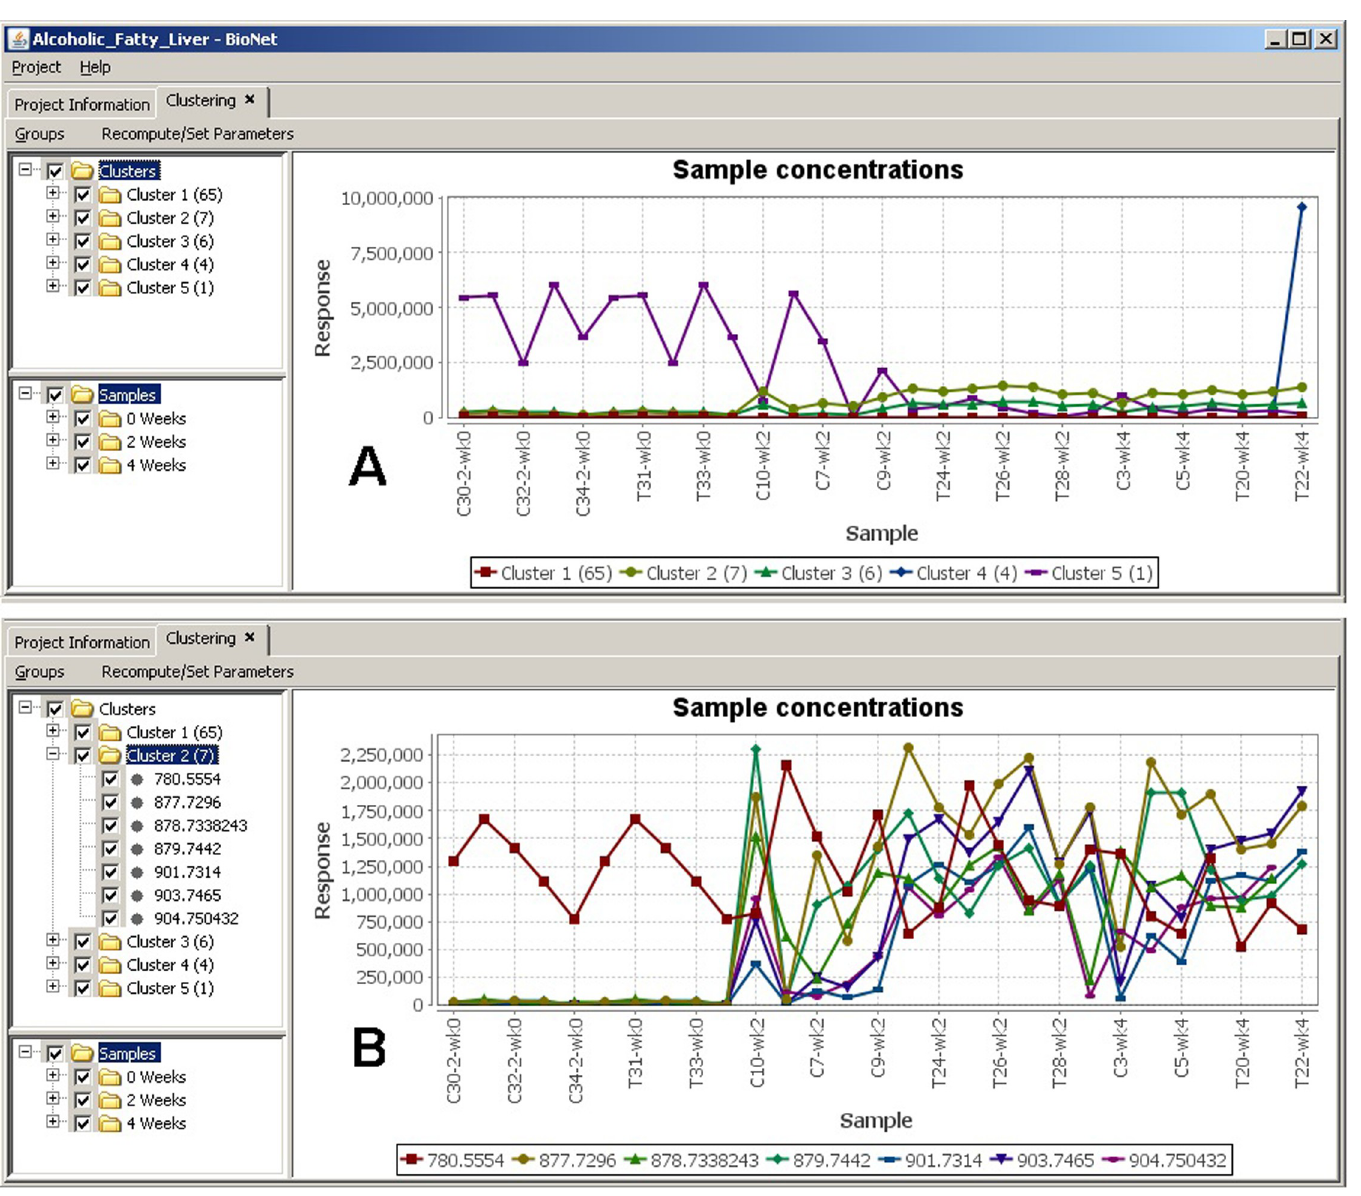
Fig 6. Clustering. (A) Clustering averages across all samples, (B) Cluster 2 molecules concentration details across all samples.